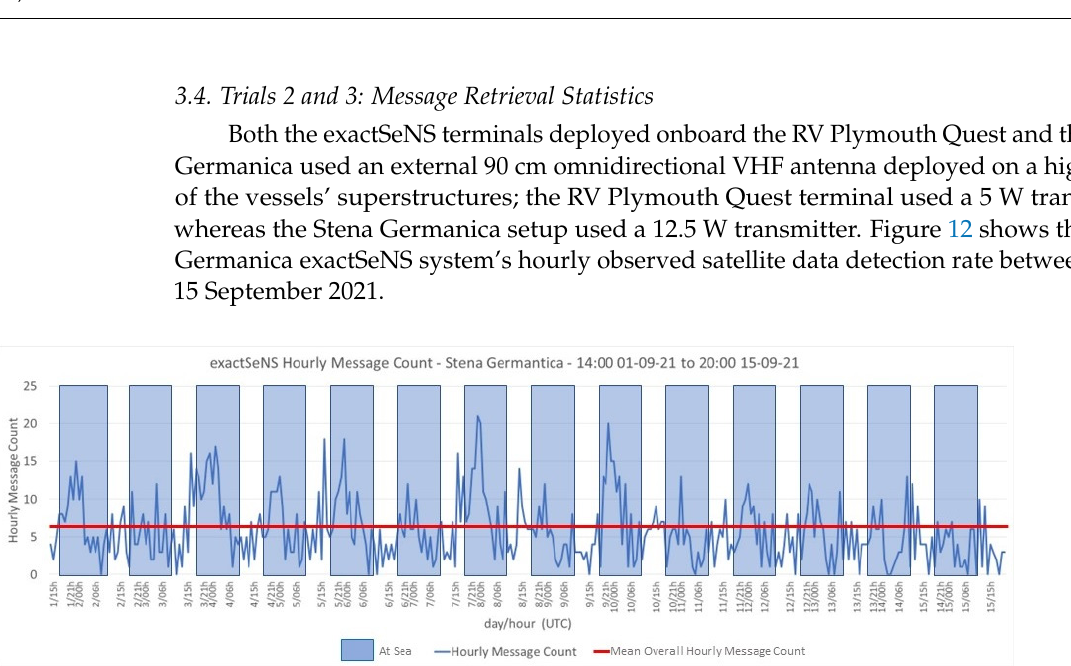
Figure 11. Comparison of SEMS 1 Hz data and S-AIS data from 2 September to 3 September 2021, where the S-AIS data transmission was successful.